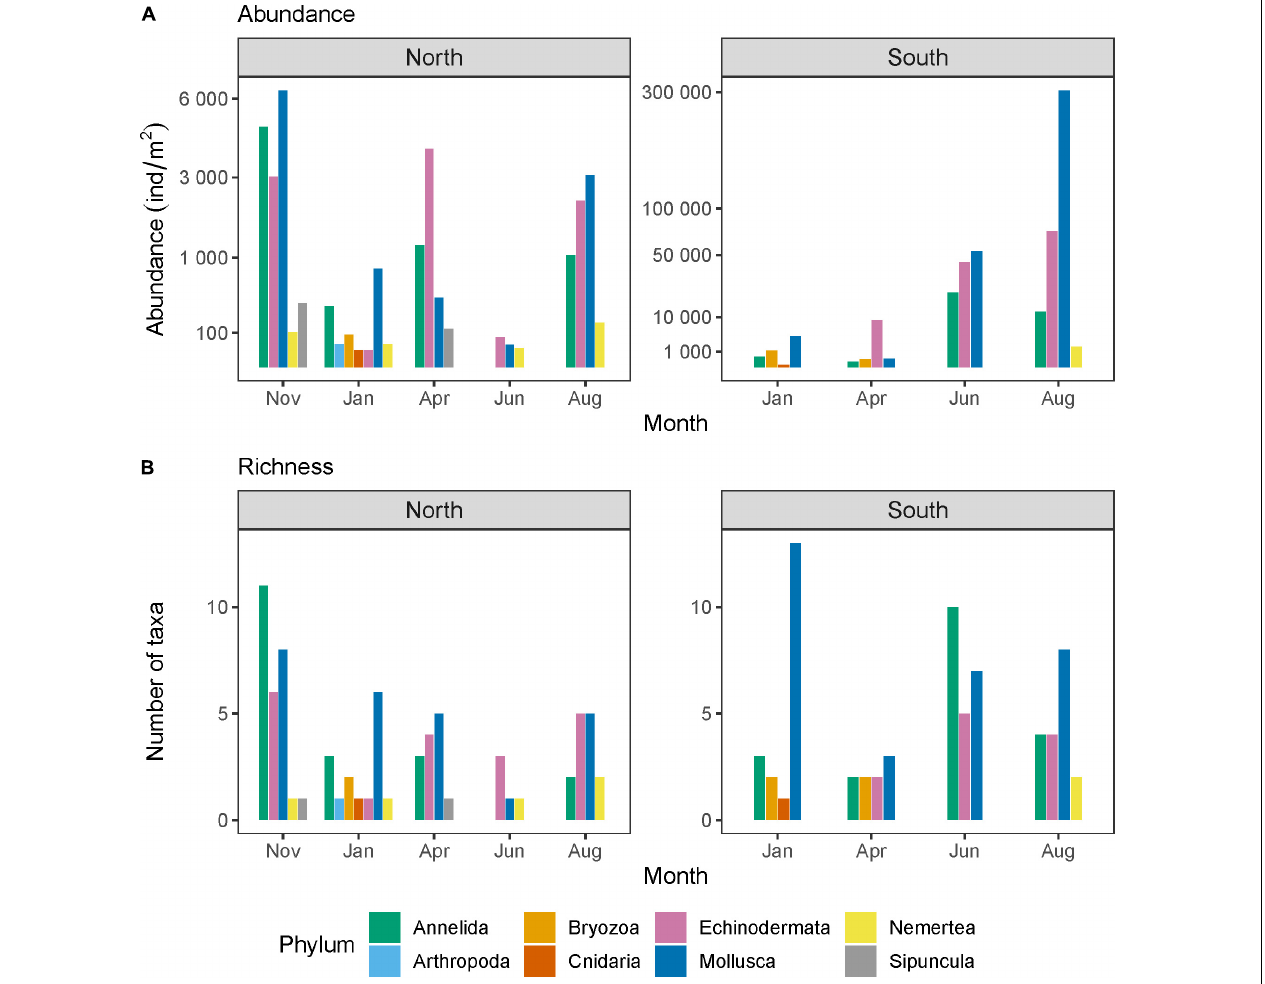
FIGURE 4 | Meroplankton (A) abundance integrated across the water column as well as (B) taxon richness north and south of the Polar Front across seasons. Note that the y-axes in panel (A) differ between the locations north and south of the Polar Front and that they are square-root transformed to facilitate visualization of lower values. Also note that the April sampling “north” of the Polar Front occurred closer to the Polar Front than the other time points and that no data are available for November south of the Polar Front.